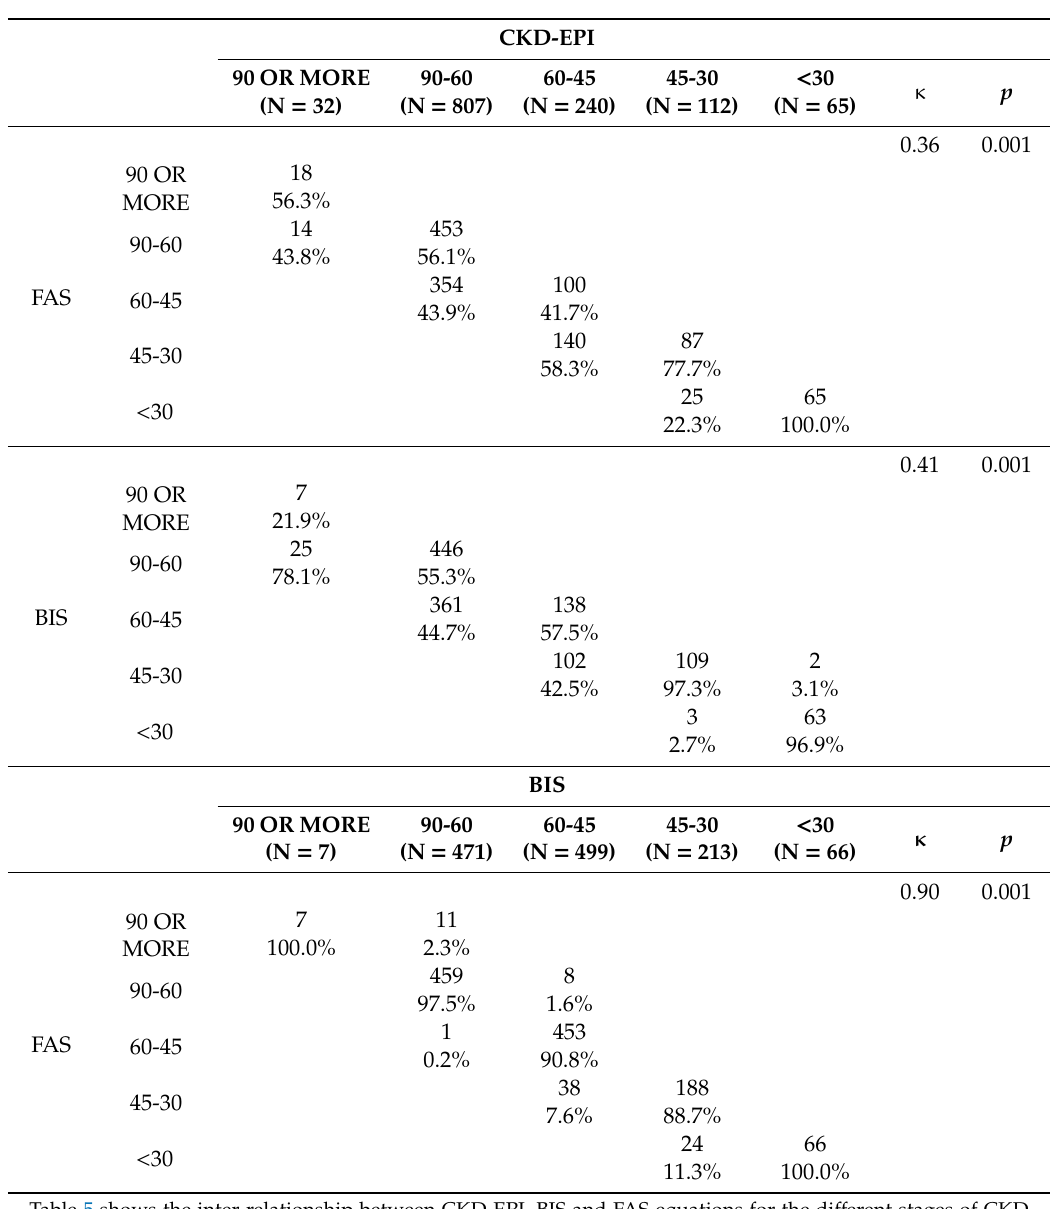
Table 5. Agreement among eGFR equations studied in women comparing CKD-EPI, BIS and FAS